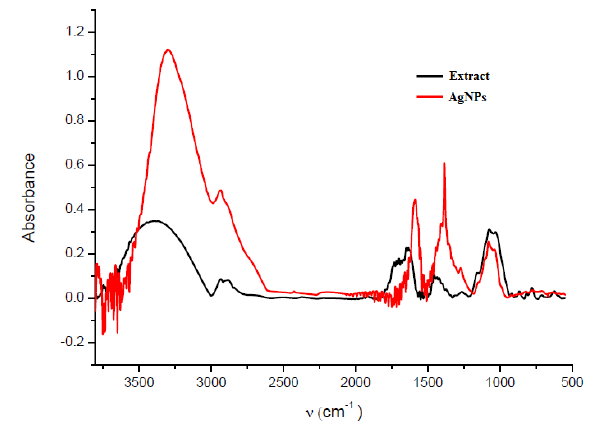
Figure 5. Fourier transform infrared (FTIR) spectra of fruit extract and silver